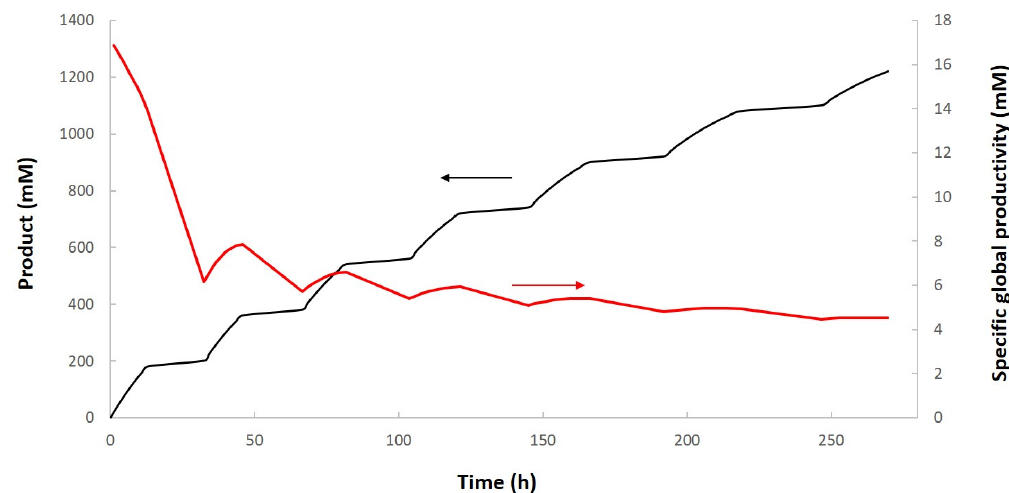
Figure 7. Product and specific global productivity over time, during the operation of the successive batch enzyme reactor with monophasic first-order inactivation kinetics, k d = 0.022 h and reactivation k r = 0.1 h –1 . Black line—Product (mM); Red line—Global specific productivity (mM/h·g biocat ). By increasing the number of batches, the life of the biocatalyst is also increased (Figure 8). Processes 2020 , 8 , x FOR PEER REVIEW